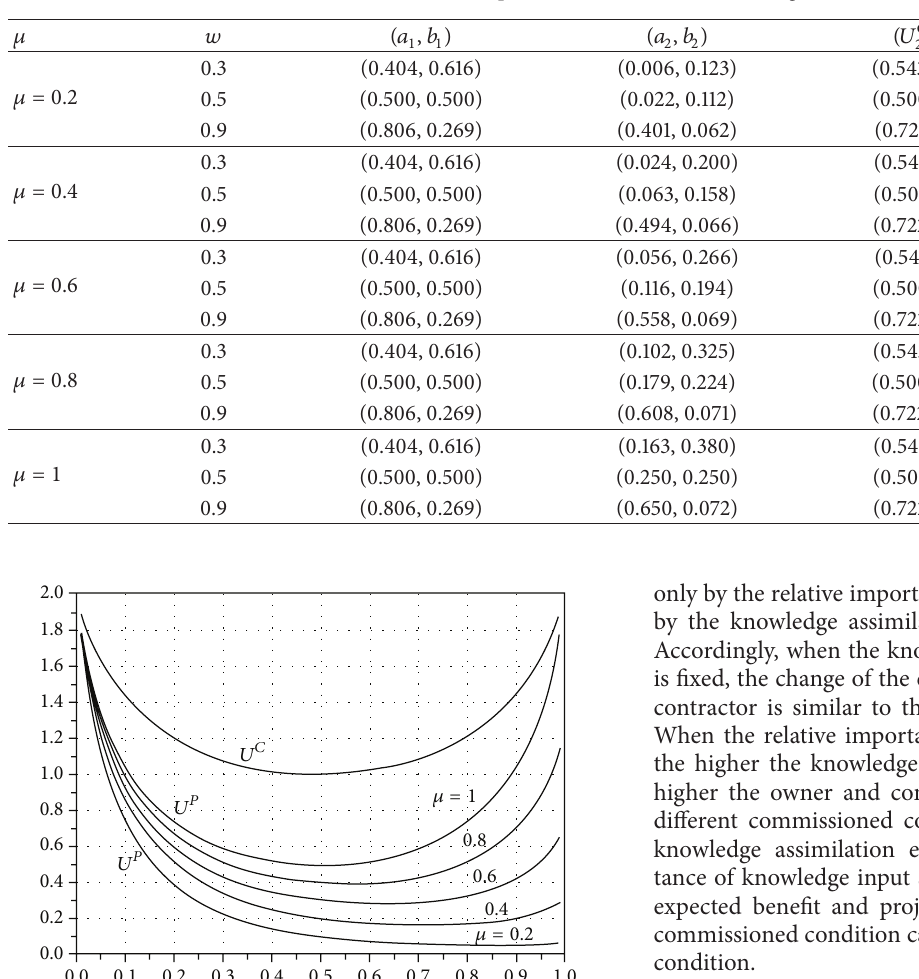
Table 1: Results comparison under different knowledge division model.